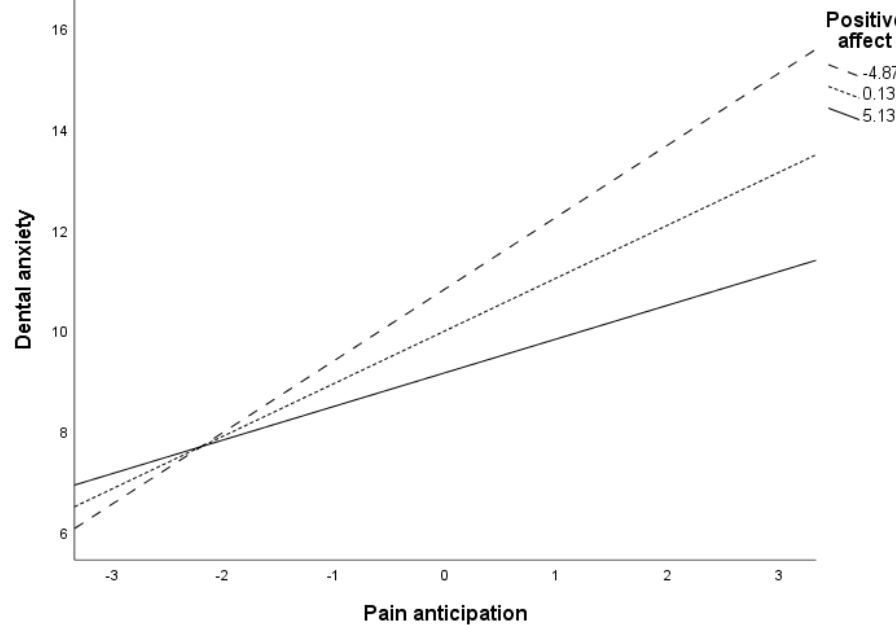
Figure 2. Pain anticipation on dental anxiety at different levels of positive